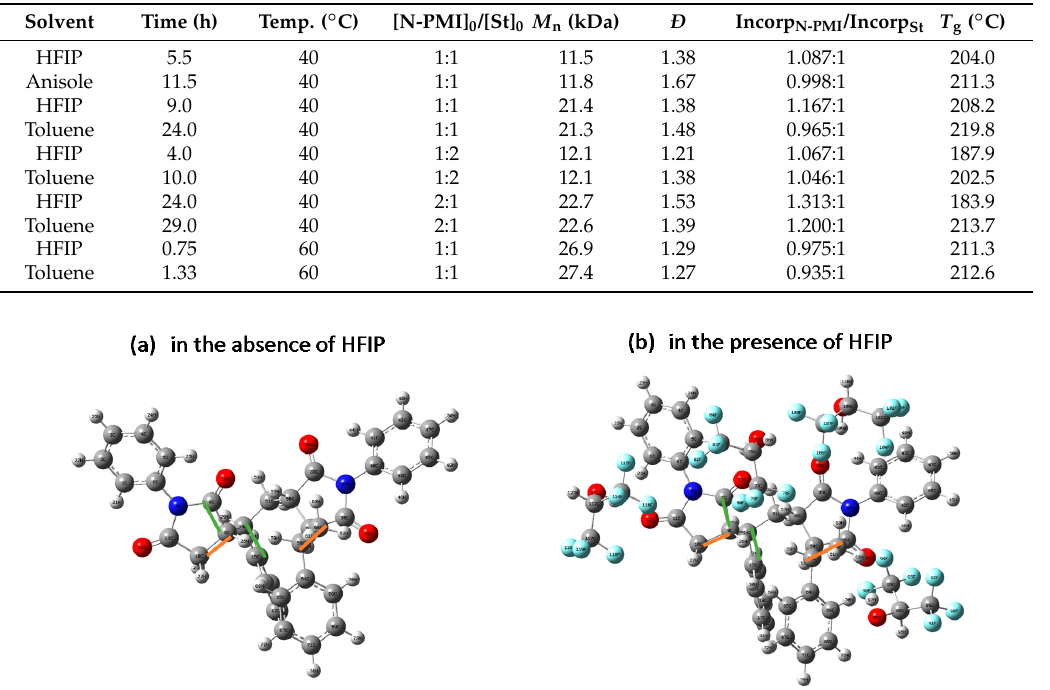
Figure 5. Computer simulation of tetrad alternating chain (N-PMI-St-N-PMI-St) conformation by using semi-empirical quantum chemistry method with pm6 implemented in the GAUSSIAN 09 package. ( a ) In the presence of HFIP; ( b ) In the absence of HFIP.